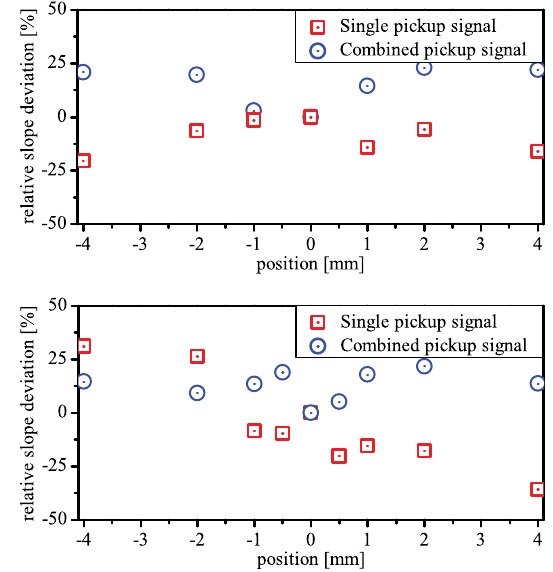
FIG. 3. Signal slope dependence of the orbit change for single and combined signal. Top: Horizontal orbit scan. Bottom: Vertical orbit